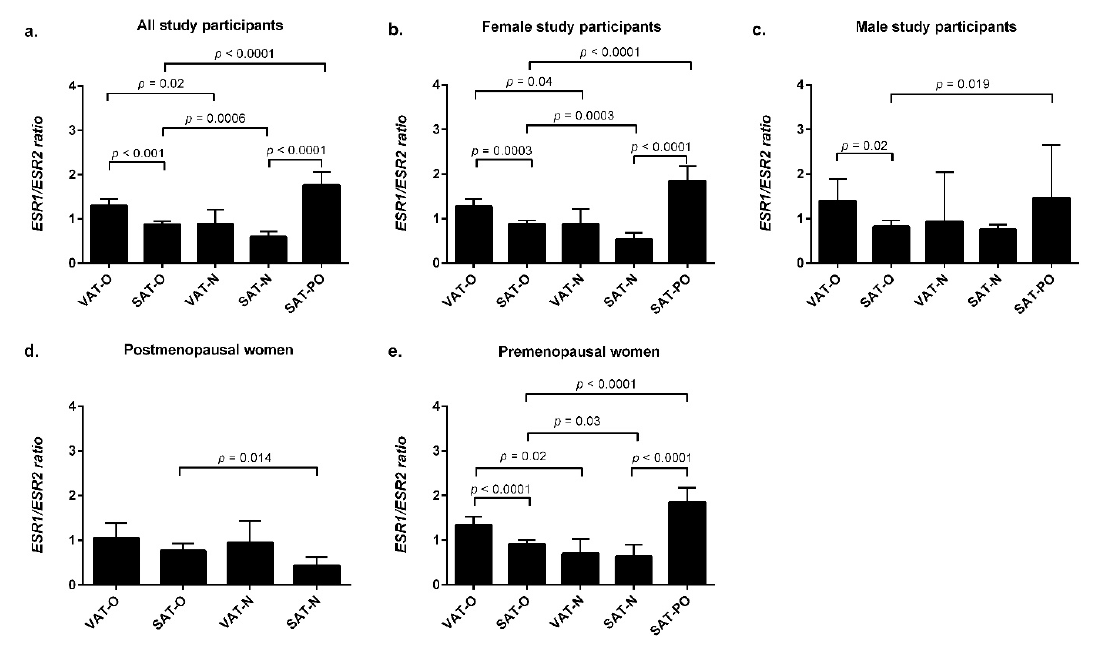
Figure 3. The ESR1 / ESR2 mRNA ratio in the visceral (VAT) and subcutaneous (SAT) adipose tis ‐ sues of obese individuals before (O) and after surgically induced weight loss (PO) and in normal ‐ weight subjects (N). Results are presented as the median with the interquartile range for the whole group ( a ), women ( b ), men ( c ), postmenopausal women ( d ), and premenopausal women ( e ).